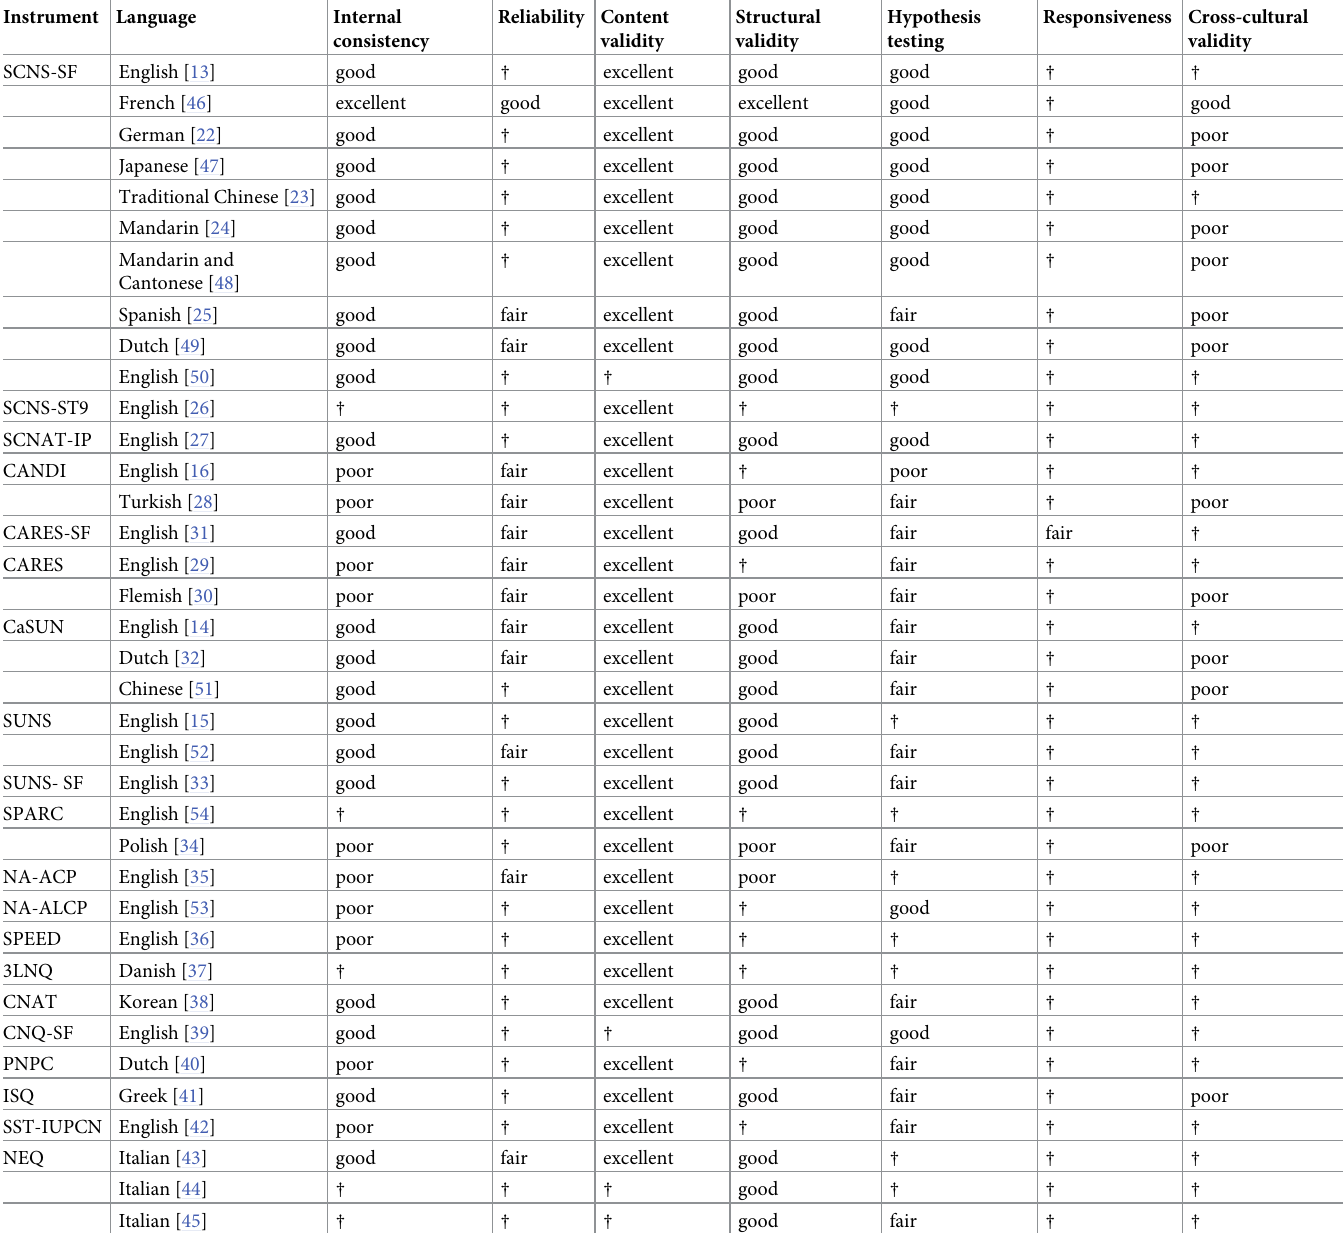
Table 2. Methodological quality of the studies on needs assessment tools in cancer patients. Instrument